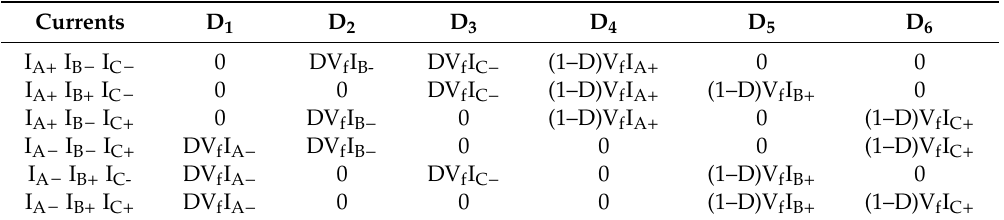
Table 2. Conduction losses of free-wheeling diodes (FWD) based on the PWM